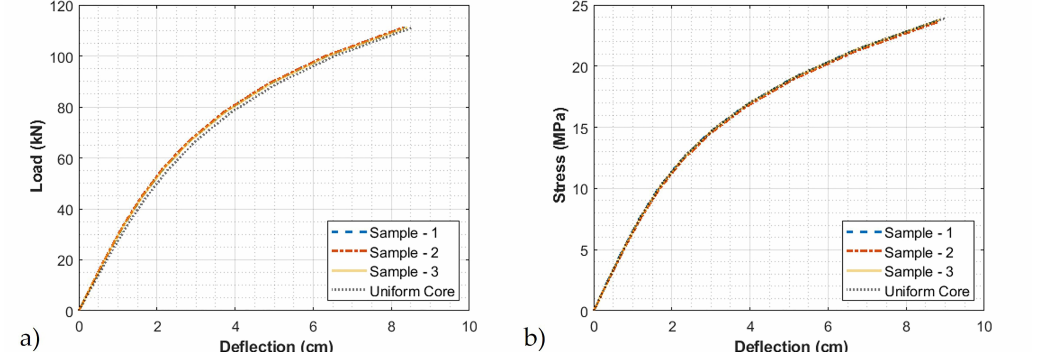
Figure 10. Results from FEA ( a ) comparing load–deflection from various samples and ( b ) comparing stress–deflection from various